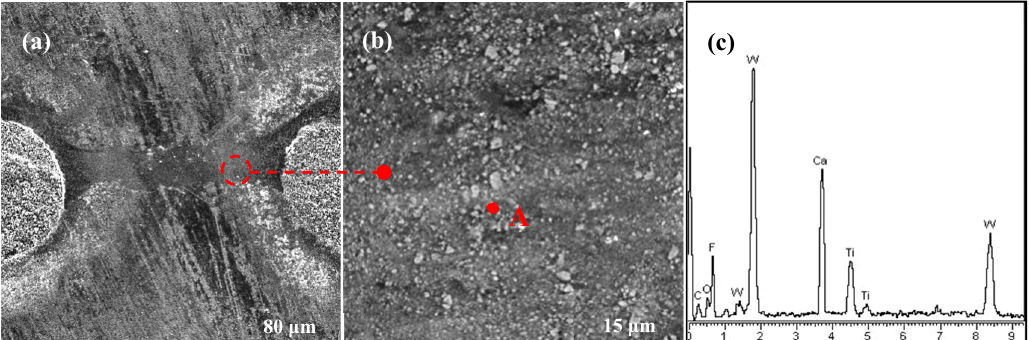
Figure 7. SEM micrographs and EDX composition analysis of the worn surface between two microholes of the SC1 sample after 15 min sliding friction at the speed of 7 mm/s and load of 50 N: ( a ) SEM micrograph of the wear scar; ( b ) enlarge micrograph corresponding to ( a ); ( c ) corresponding EDX composition analysis of point A in ( b ).